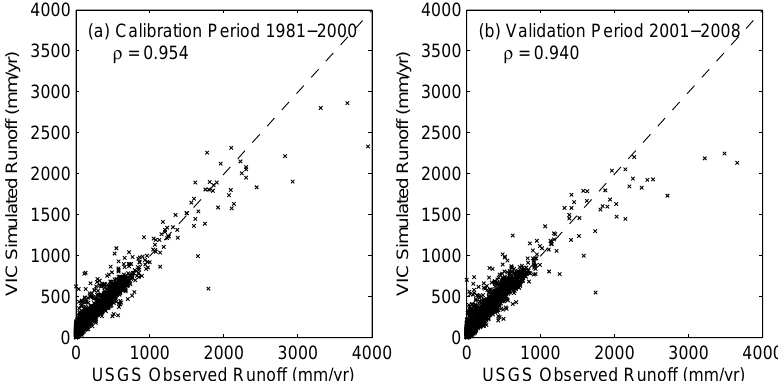
Fig. 9. The USGS WaterWatch observed runoff versus the VIC simulated annual total runoff (surface runoff + base flow) for both calibration and validation periods for each HUC8